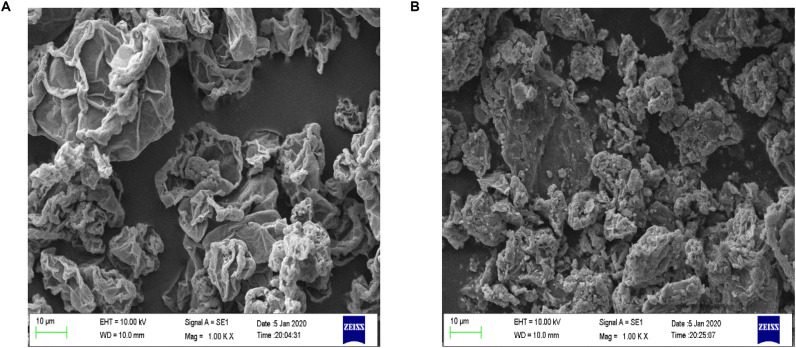
Surface morphology of GO (A) and Fe3O4@GO (B).